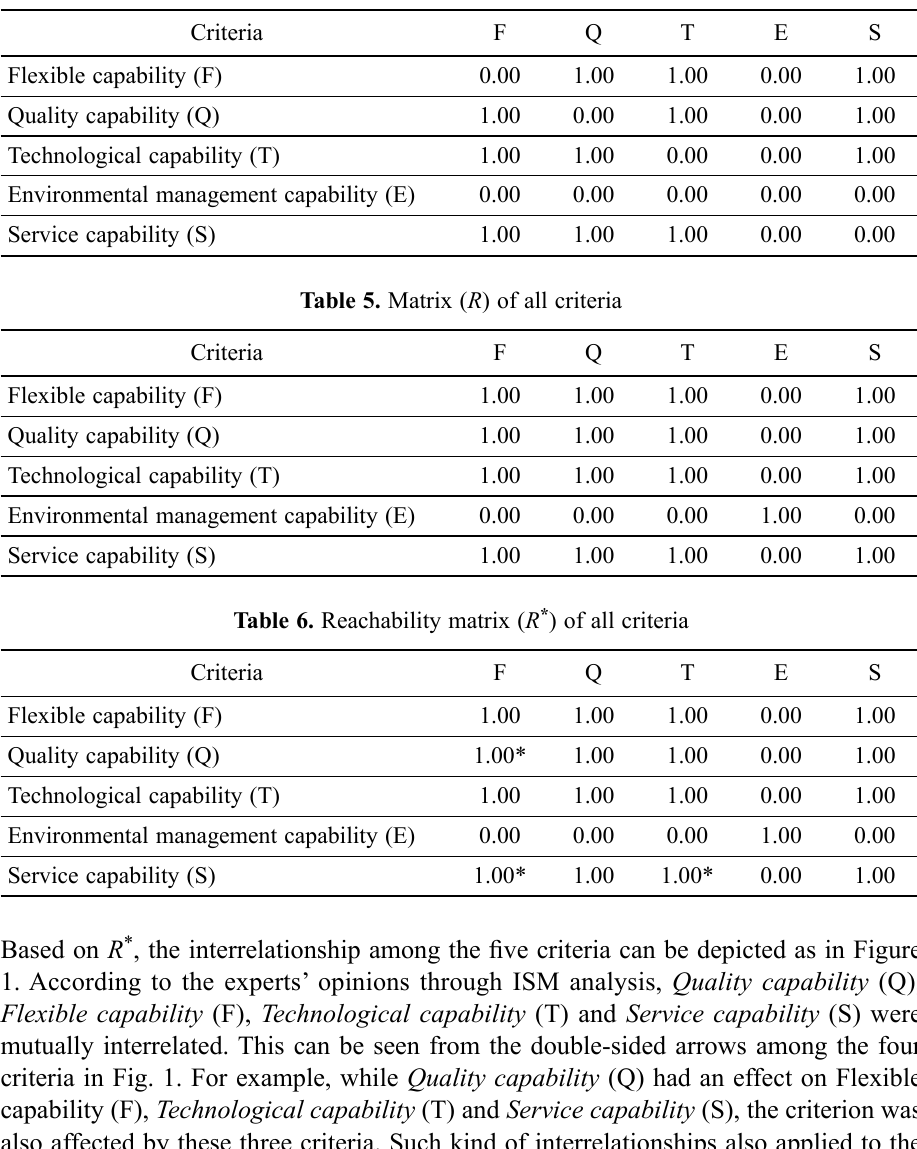
Table 4. Interrelation matrix ( A )